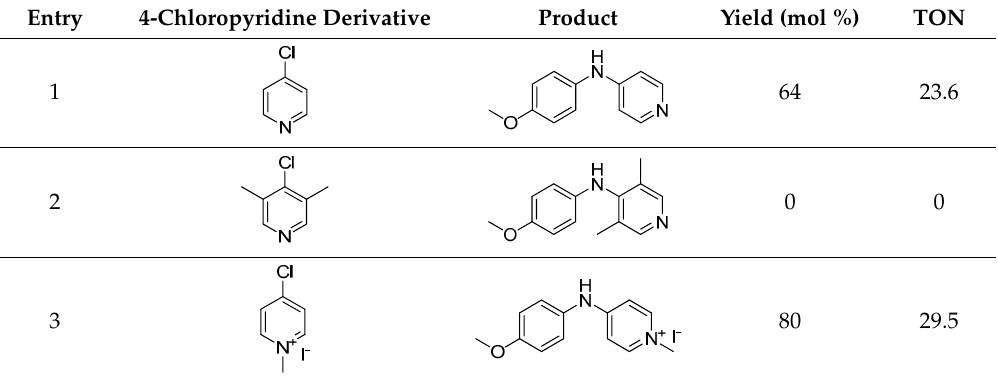
Table 3. Comparison of yields for selected 4-chloropyridine derivatives in C-N coupling reaction with 4-methoxyaniline.